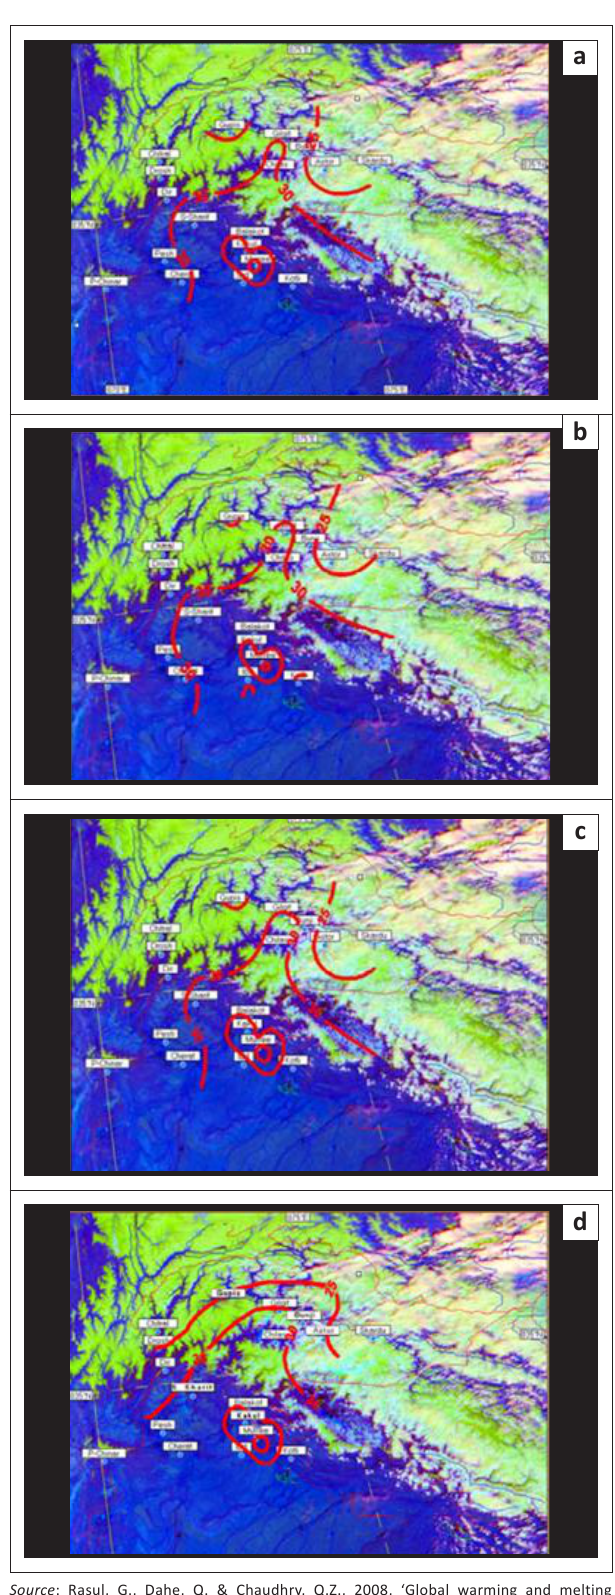
FIGURE 5: Shifting isothermic dynamics along the southern slopes of the Hindu Kush – Karakoram – Himalayas ranges showing a general northward trend. Isotherms based on mean summer maximum temperature: April – June for (a) 1991 – 1995, (b) 1995 – 2000, (c) 2001 – 2005 and (d) 2006 – 2008. Layout: Please insert upper left as (a) and upper right as (b) and lower left (c) and lower right as (d)